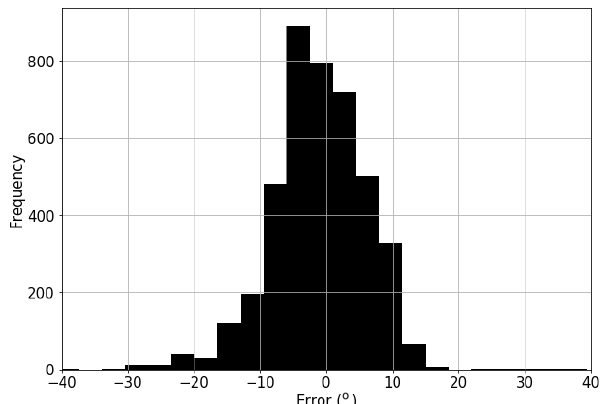
Figure 10. Error distribution of the estimated wind direction com- pared with measurements from the sodar. Note the measurements of the sodar are interpolated to match the 1min time series from the consensus